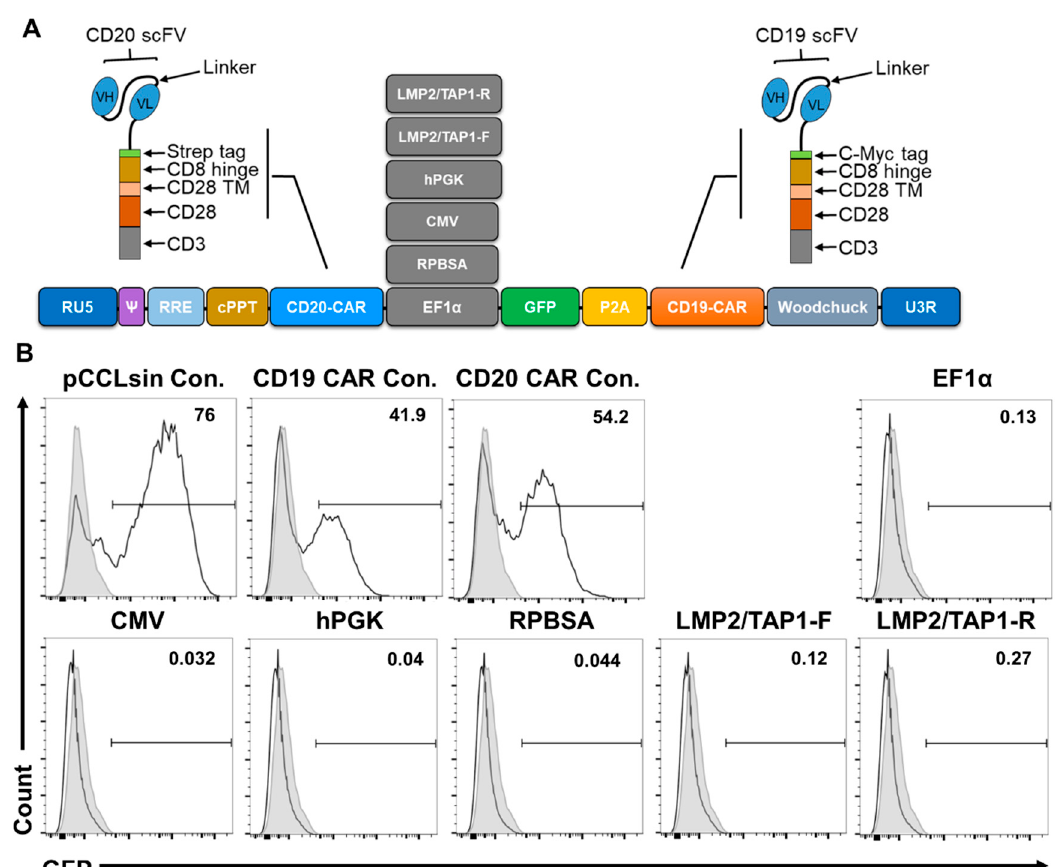
Figure 3. The e ff ect of bidirectional promoters in producing functional lentiviral particles. ( A ) Schematic illustration of the pCCLsin backbone bearing six di ff erent internal promoters (LMP2 / TAP-1R, LMP2 / TAP-1-F, hPGK, CMV, RPBSA, EF1 α ) for driving GFP-P2A-CD19CAR in the sense direction and CD20CAR in the antisense orientation. ( B ) A representative experiment for the transduction e ffi ciency of primary T cells for the six lentivectors. CD3 / CD28 stimulated human primary T cells were transduced at MOI 40 and cells were analysed for GFP expression at 72 h post-transduction by flow cytometry. Results are representative of three independent T cell donors (see text for mean and range of titres obtained for the single and dual constructs).